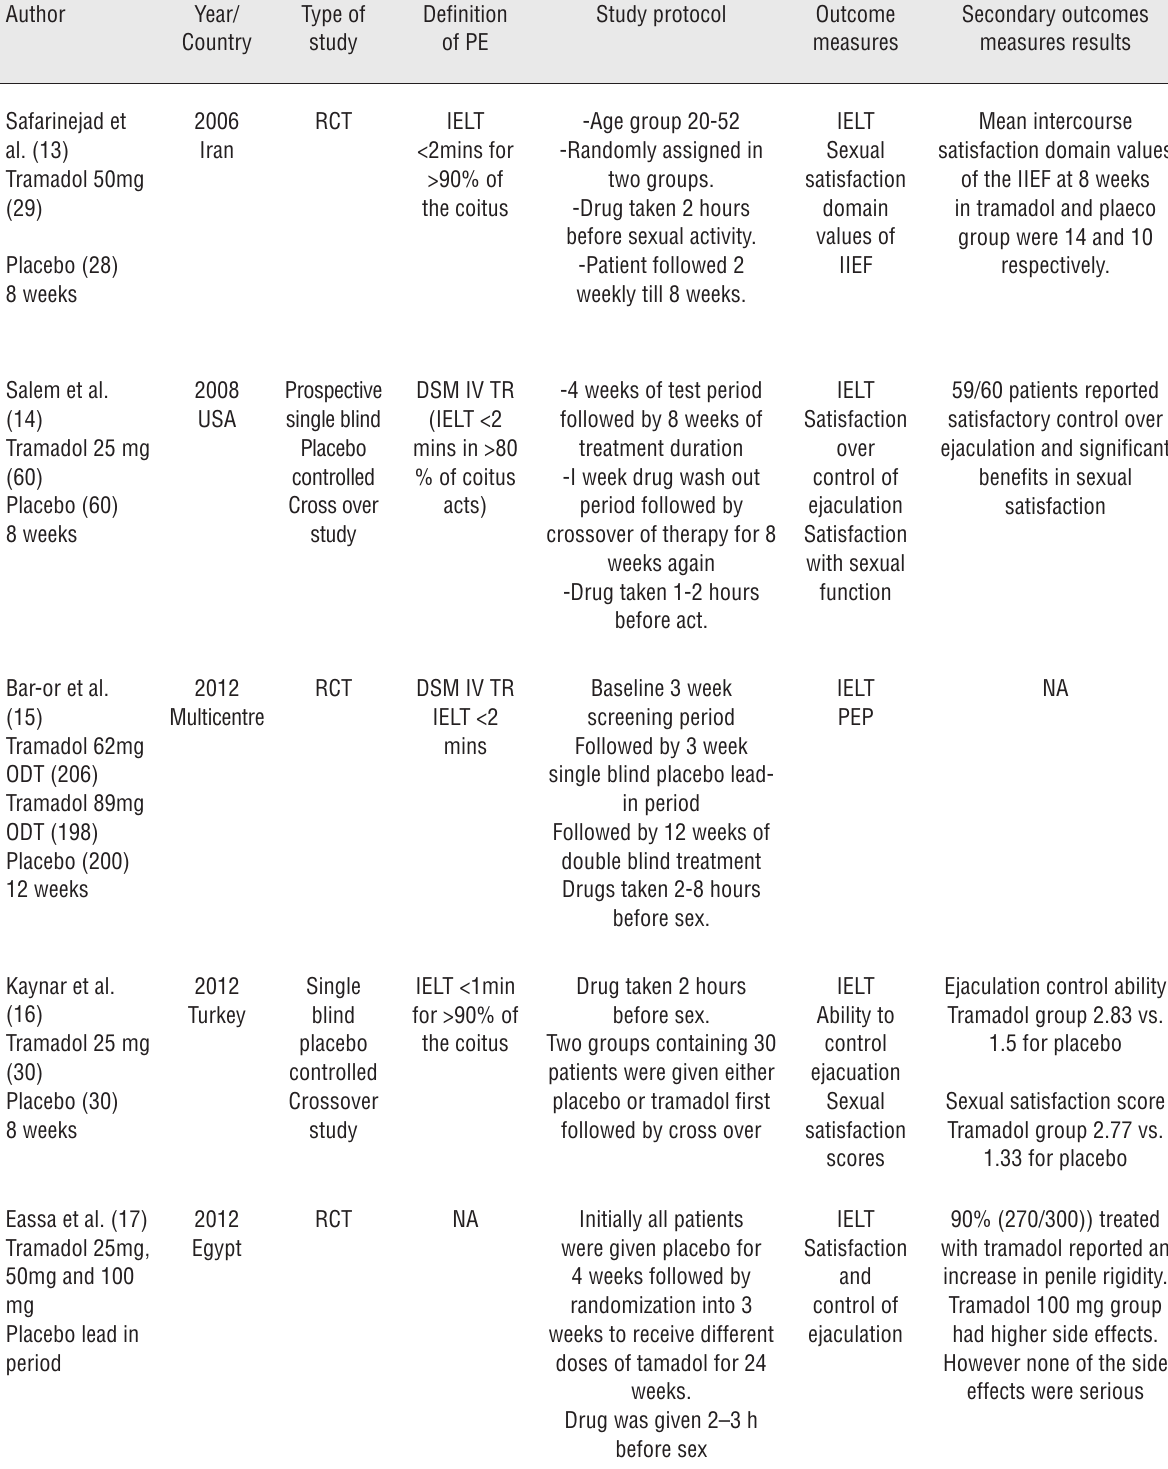
Table-1 - Characteristics of the studies included in the